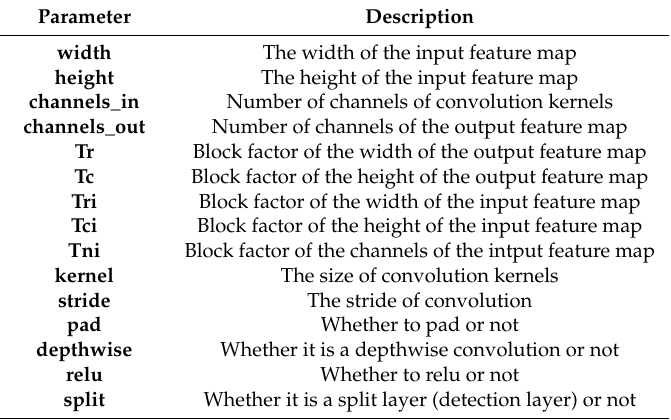
Table 1. Configurable parameters.